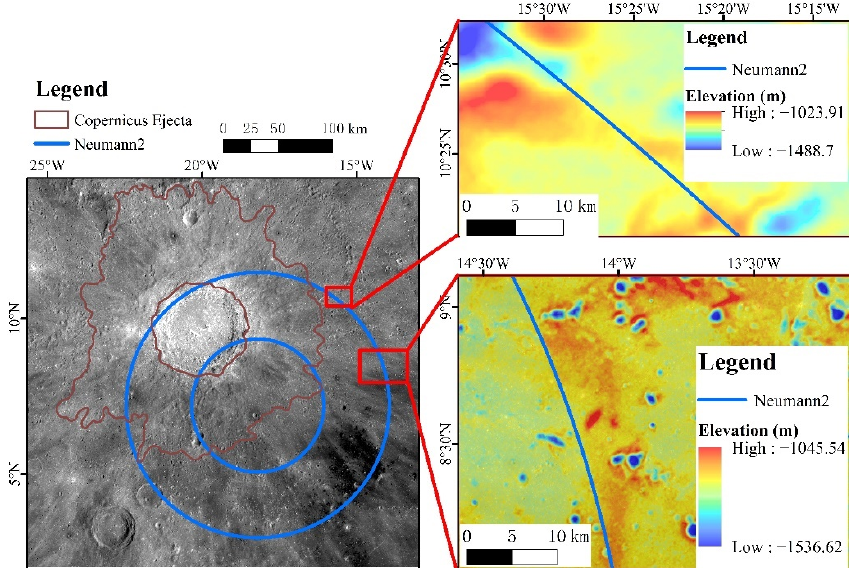
Figure 4. Surviving rim on the basin rim, as given by Neumann. The elevations are from the LOLA-SELENE Kaguya TC DEM.